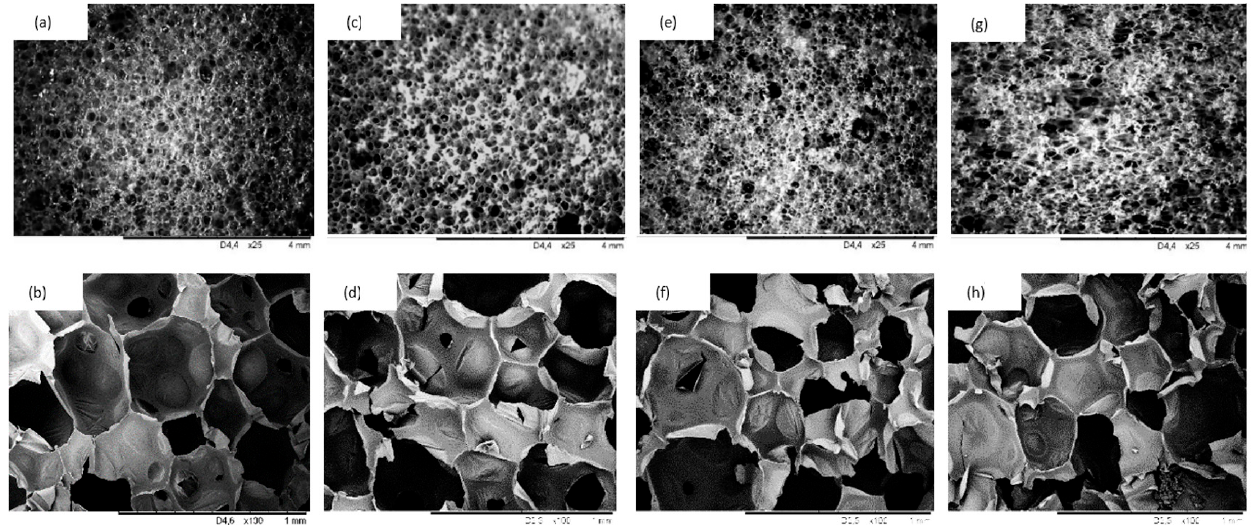
Figure 8. Scanning electron microscope images of ( a , b ) PUR_NEAT; ( c , d ) PUR_C_1; ( e , f ) PUR_C_2; ( g , h ) PUR_C_5.